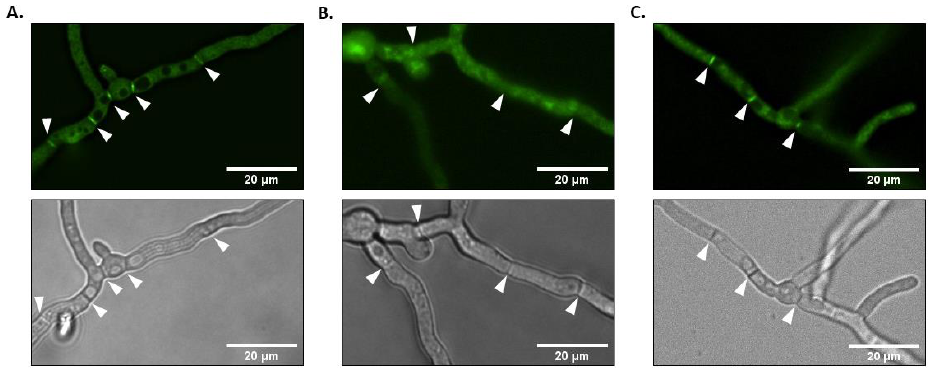
Figure 4. GFP- rsrA is concentrated at septa in an actin-dependent fashion. ( A ) One thousand conidia of the Δ rsrA + GFP -rsrA strain were incubated in GMM broth for 14 h at 37 °C. B. GFP -rsrA localization is actin-dependent. One thousand conidia were cultured in GMM for 14 h at 37 °C. The medium was then replaced by fresh GMM containing 10 µg/mL of cytochalasin A ( B ) or DMSO ( C ) and cultures were incubated for an additional 2 h. Note that the addition of 2% DMSO had no effect on hyphal development or localization of GFP -rsrA . Microphotographs were taken with a Nikon X fluorescence microscope equipped with a GFP filter. White arrows indicate septa.